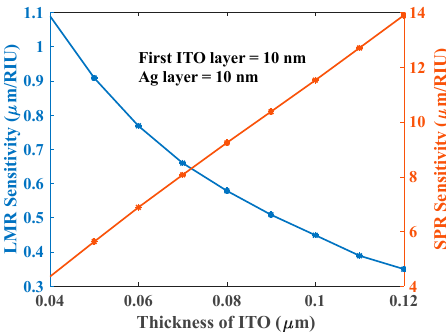
Figure 9. Sensitivity of the First LMR and SPR dip with the variation of the third ITO layer when the first layer is ITO (10 nm) and the second layer is Ag (10 nm) and RI of the sensing medium varies from 1.33 to 1.36 RIU.